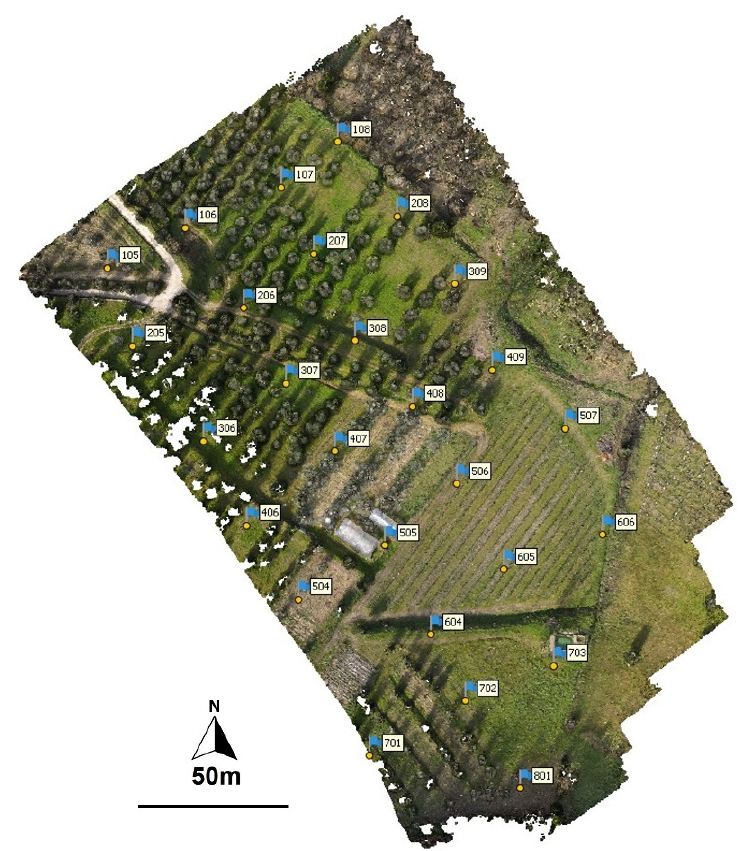
Figure 9. Sparse point cloud of the NW area.